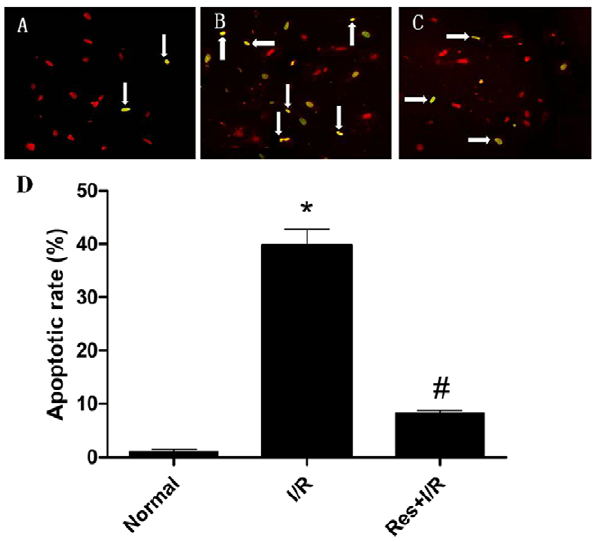
Figure 2. TUNEL staining and the apoptotic rate of cardiomy- ocytes. The arrow refers to apoptotic cells. (A) In the normal group, a very few apoptotic cells were found. (B) In the I/R group, the apoptotic cells increased dramatically. (C) In the Res + I/R group, the number of apoptotic cells was far less than that in the I/R group, which suggested that Res lowered cell apoptosis induced by I/R. (D) The statistical data of apoptotic rate. * P , 0.01 versus normal group, # P , 0.01 versus I/R group. Values are the means 6 SD, n=10 in each group.